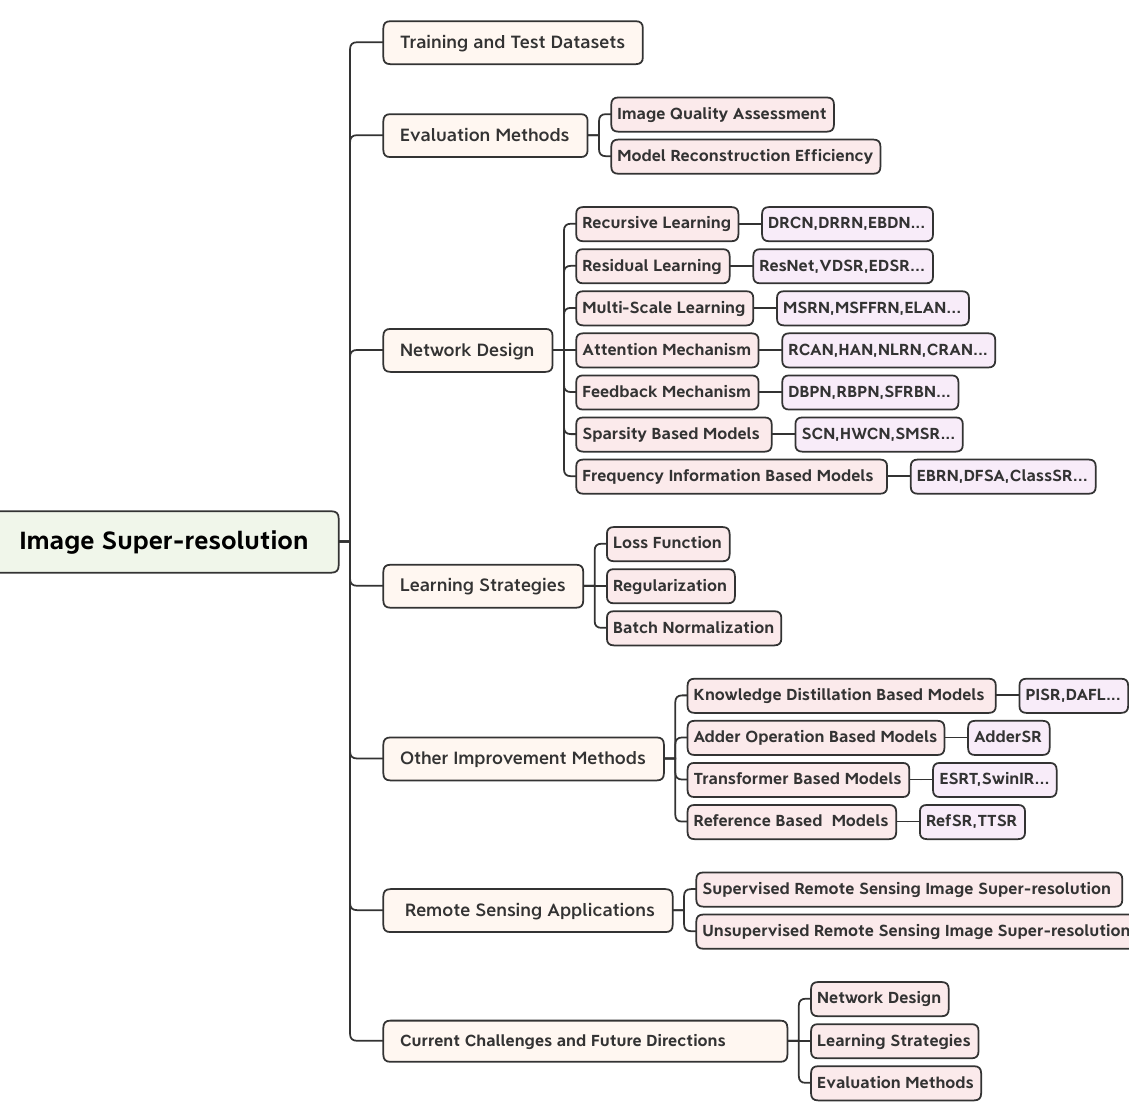
Figure 2. Hierarchically structured classification of SR in this